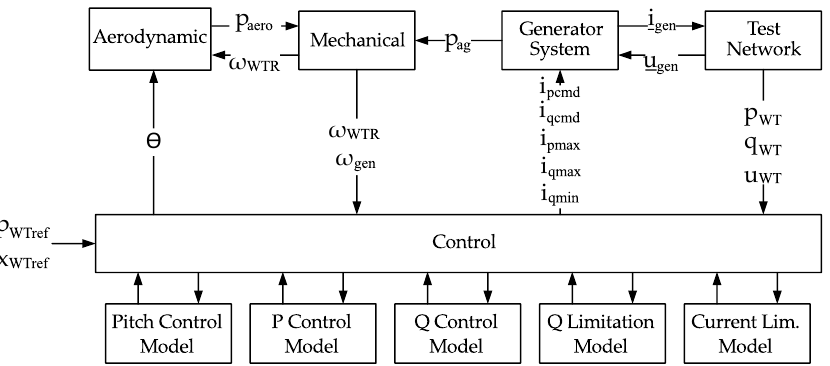
Figure 1. Modular structure of the generic Type 3 WT adapted from